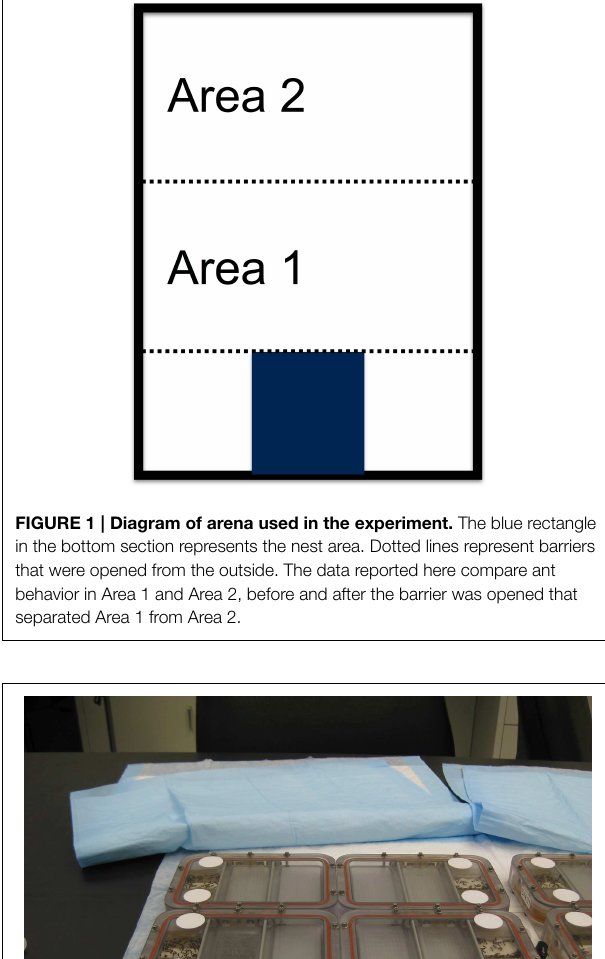
Jacob Burrows Freeman. One section, at one end of the arena, was a nest area of 23 by 23 mm, of which 23 by 13 mm was plaster of Paris. This plaster area was moistened with 12 ml of Sigma-Aldrich Minimum Essential Medium Eagle that had 0.03% methylparaben v/v added to it to prevent mold. The floor of the arena had a rougher surface, of Delrin plastic, than the polycar- bonate ceiling, and the ants in microgravity mostly clung to this rougher surface; very few ants walked on the other, smoother, ceiling surface of the arena. Each arena had an inner dimension of 8 by 11.1 cm, divided into three sections, separated by metal barriers that could be turned, using a wrench on the outside of the arena, until the barrier was flush with the arena